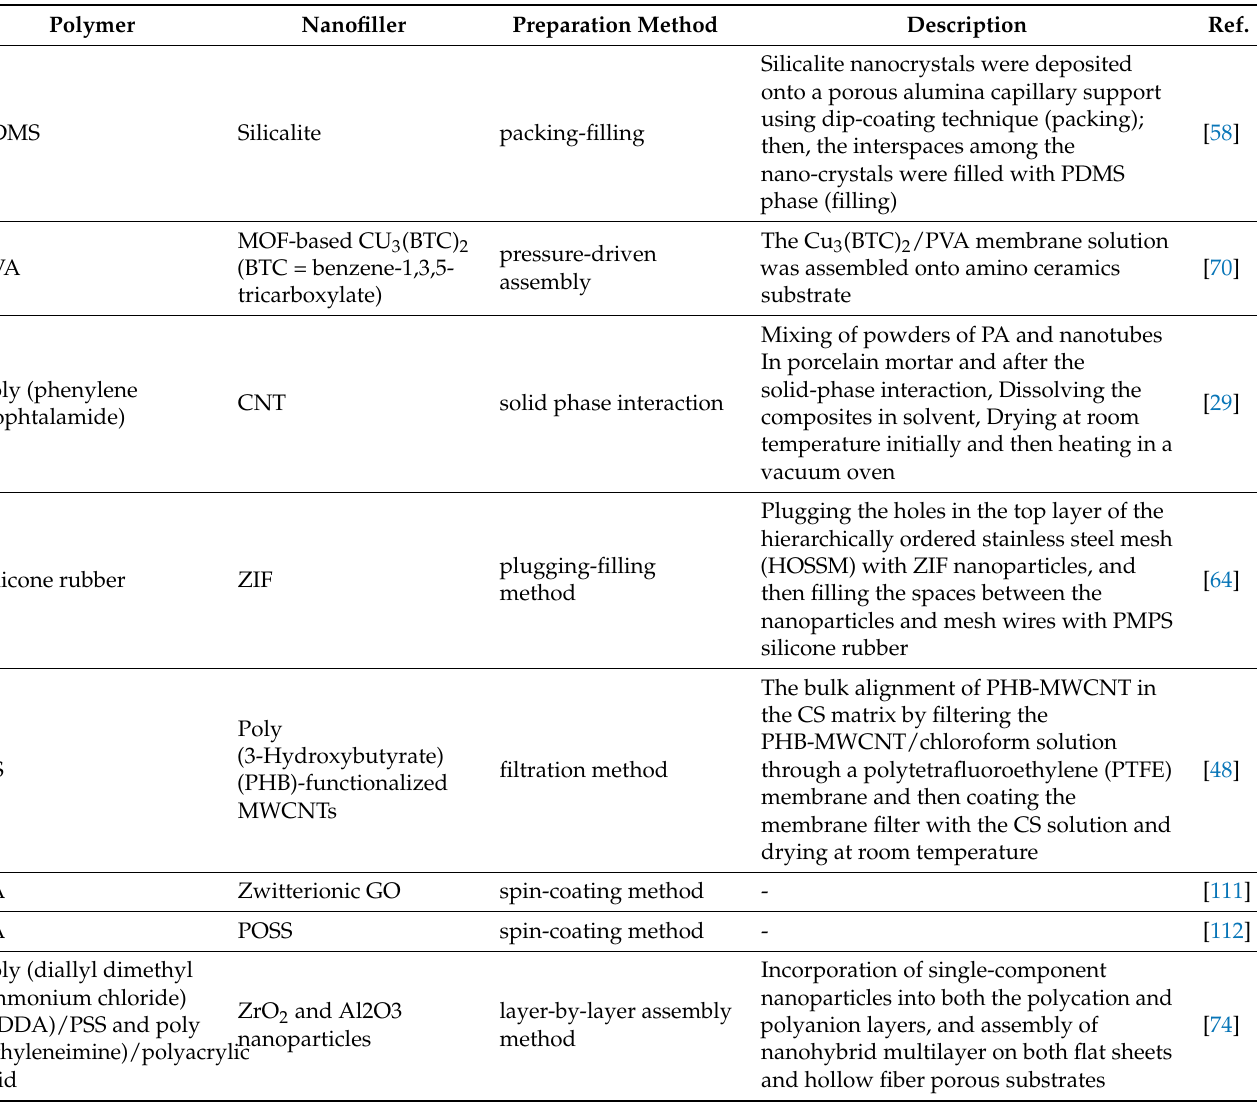
Table 5. PV nanocomposite membranes reported in the literature prepared using methods other than blending, polymerization, and